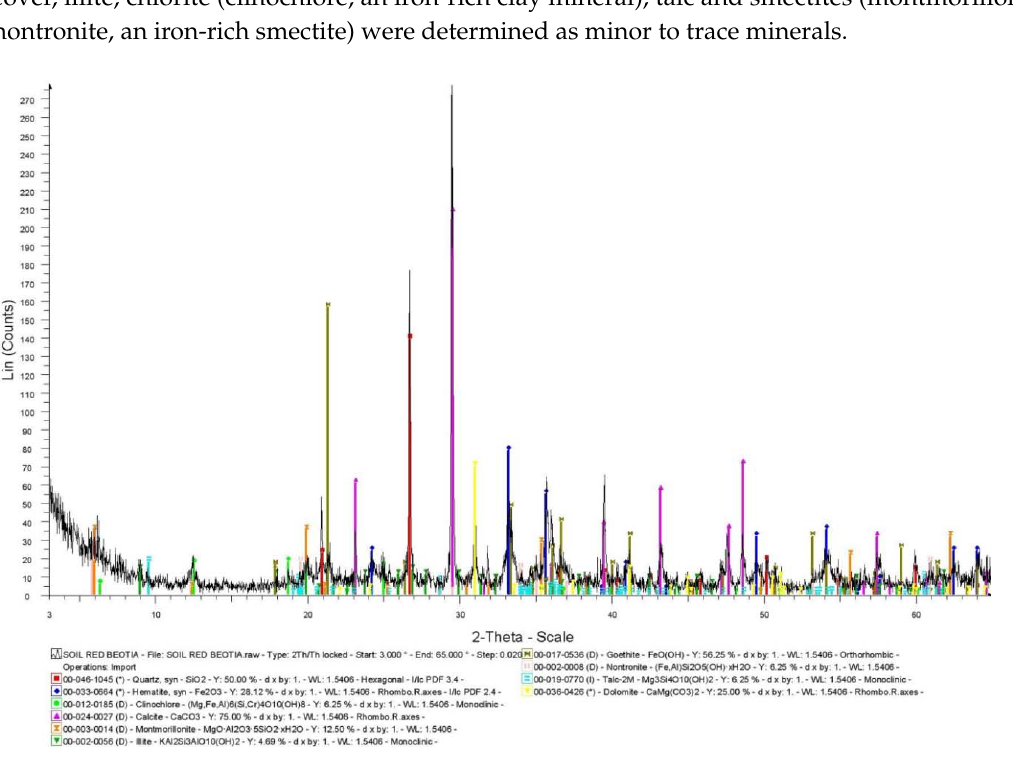
Figure 1. XRD diagram of soil 1.